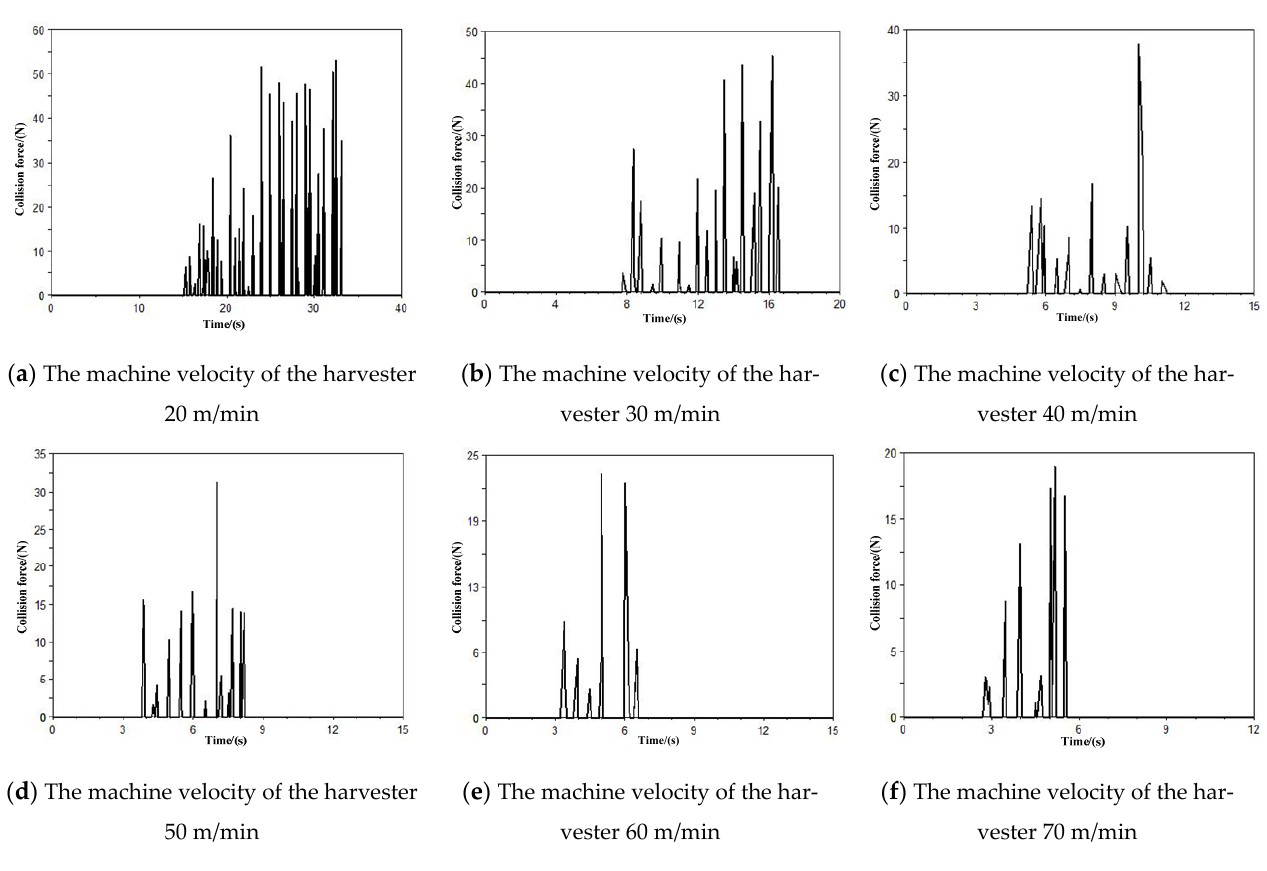
Figure 18. Analysis of the influence of the machine velocity on the harvesting collision force. The interaction collision process between the finger rows of the harvester and the blueberry branch shows that when the first collision occurred, the blueberry branch changed from stationary to a moving state under the action of the collision force. At the initial moment after the collision, the branch acquired the initial collision velocity, and the velocity direction was the action direction of the collision force; subsequently, under the action of the structural damping ξ of the branch, the collision velocity decayed rapidly to 0, and at this moment the branch produced deflection deformation. The branch began to move reversely under the action of the branch deformation force, and the velocity in- creased from 0, with a certain relative motion velocity to contact the finger rows, which went the opposite direction of motion. Then, the second collision occurred, which meant that the branch possessed a certain relative motion velocity, and the collision force gener- ated by the second collision was greater than the first collision force. With the continuation of interaction times between the figure rows and the branch, the number of collisions gradually increased, the relative motion velocity of the branch gradually increased, and the collision force gradually increased. Conversely, with the increase in the machine ve- locity of the harvester, the interaction time between the two decreased, the number of collisions also gradually decreased, the relative movement velocity of the branch gradu- ally decreased, and the collision force gradually decreased, forming the collision force variation curves in Figure 18a–f. When the rotational velocity of the hydraulic motor of the harvesting system was set to 120 r/min and the machine velocity of harvester was set to different values, the fruit harvesting force curves were obtained according to the harvester and plant harvesting force measurement points, which are shown in Figure 19a–f. ( a ) The machine velocity of the harvester 20 m/min